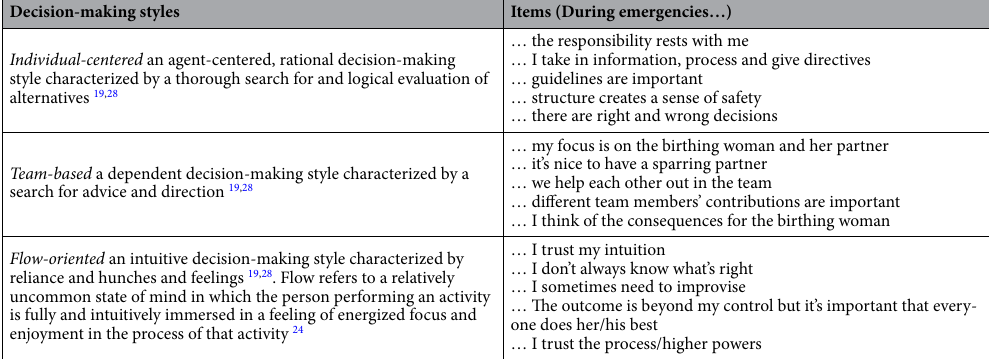
Decision-making